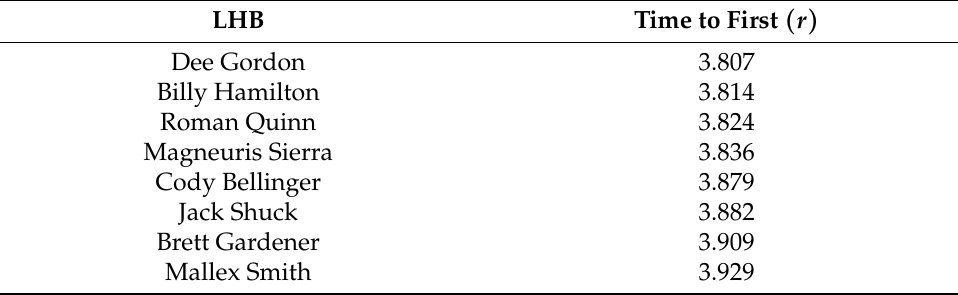
Table 1. Fastest time to first ( r ) for left-handed batters (LHB) in seconds,